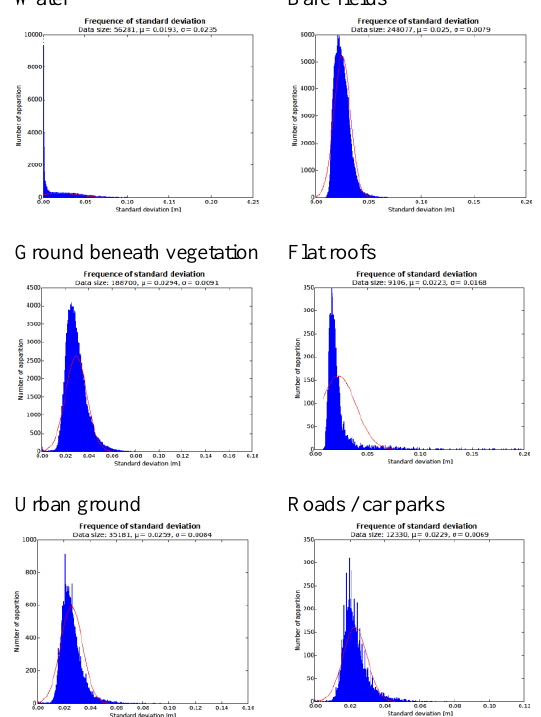
Figure 14. Histograms of height precision by class (note, to aid interpretation, histograms are displayed with differing